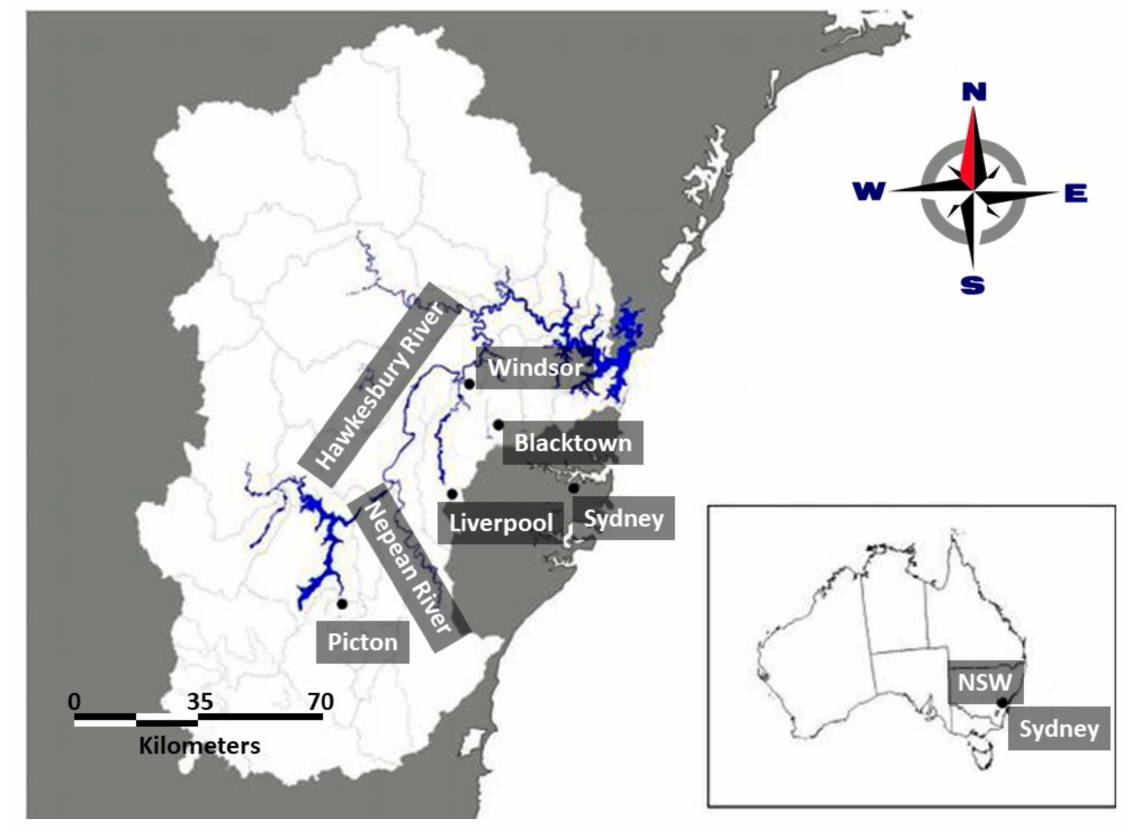
Figure 1. The Hawkesbury-Nepean